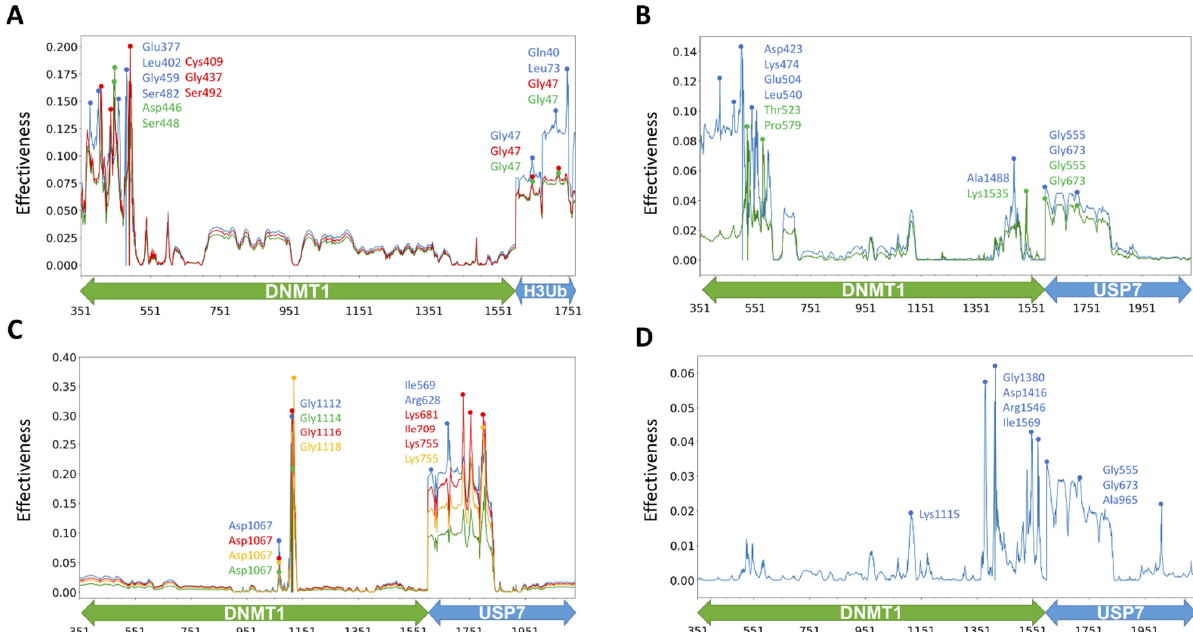
Figure 7. PRS results for some disease mutations and PTMs in two DNMT1 complexes. Effectiveness profiles for ( A ) DNMT1-H3Ub by the perturbation of three disease mutational hotspots of Thr481 (the blue line), Asp490 (the green line), and Pro491 (the red line), for DNMT1-USP7 by the perturbation of ( B ) two disease mutational hotspots of Lys505 with the blue line, Tyr524 with the green line, ( C ) four interfacial acetylation sites (Lys1111 with the blue line, Lys1113 with the green line, Lys 1115 with the red line, Lys1117 with the orange line) and ( D ) Lys 1415 at distant site.